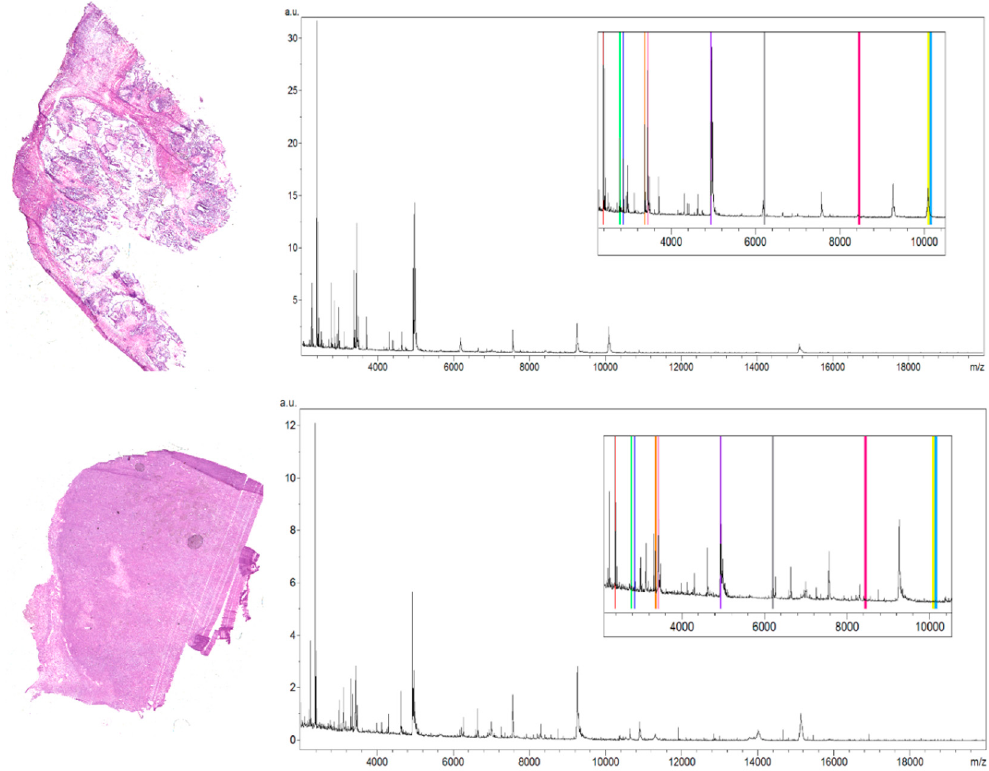
Figure 1. Hematoxylin and eosin stained tissue sections of a low-grade serous borderline ovarian tumor (top picture) and ovarian fibrothecoma (bottom picture) next to the averaged spectra of the analyzed tissue sections. For each spectrum, the zoomed fragment is presented with color-labeled regiospecific peaks within the borderline tumor tissue section (m/z: 2775.79 (green), 2861.35 (navy blue), 3368.34 (orange), 3438.43 (pink), 4936.37 (purple)) and peaks differentiating these two tissue sections (m/z: 2386.53 (red), 6204.735 (grey), 8453.171 (magenta), 10,146.87 (blue), 10,092.39 (yellow)).